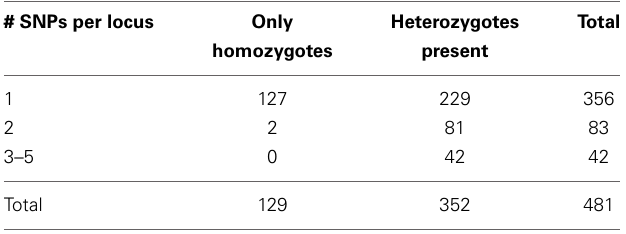
Table 1 | Distribution of RAD tag loci according to the number of polymorphic sites per locus and presence or absence of intraindividual